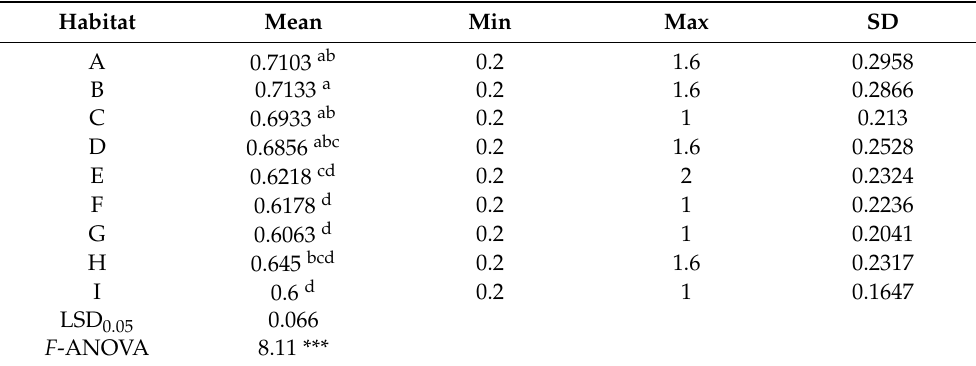
Table 5. Mean values, minimal, maximal and standard deviations (SD) as well as homogenous groups of exine thickness (Ex), A–I abbreviated habitat names (see: Table